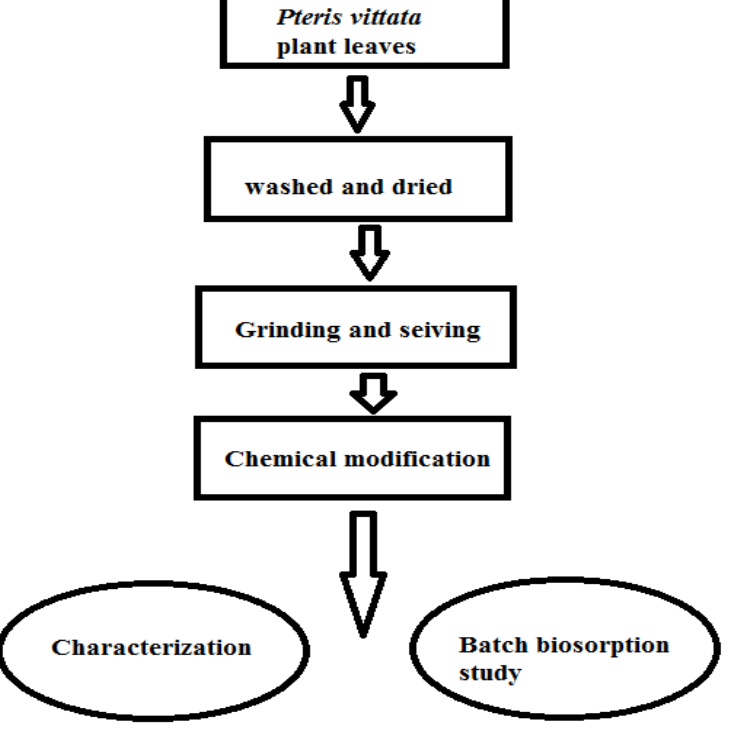
Figure 1. Protocol of CMPVL preparation.